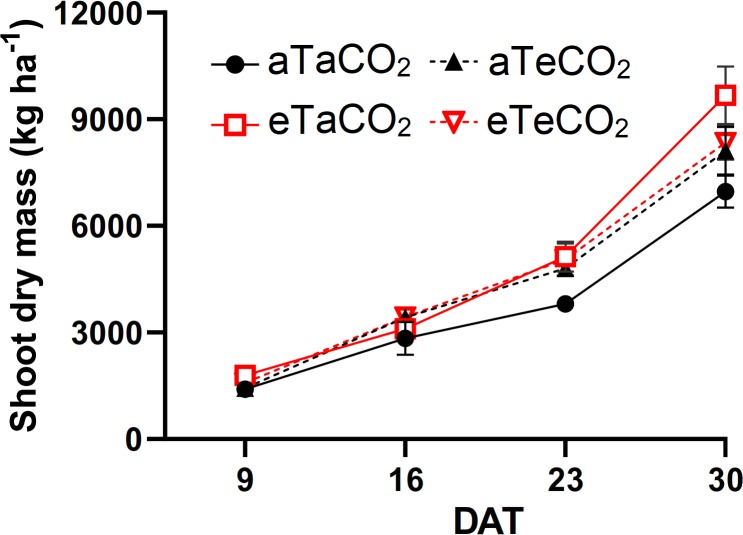
Shoot dry mass of P. maximum during the experiment at 9, 16, 23 and 30 days after treatments (DAT).Treatments: aTaCO2 (ambient temperature and ambient [CO2]), eTaCO2 (2°C above ambient temperature and ambient [CO2]), aTeCO2 (ambient temperature and 200 ppm above ambient [CO2]), and eTeCO2 (2°C above ambient temperature and 200 ppm above ambient [CO2]). Bars show means and SE of four replicates.